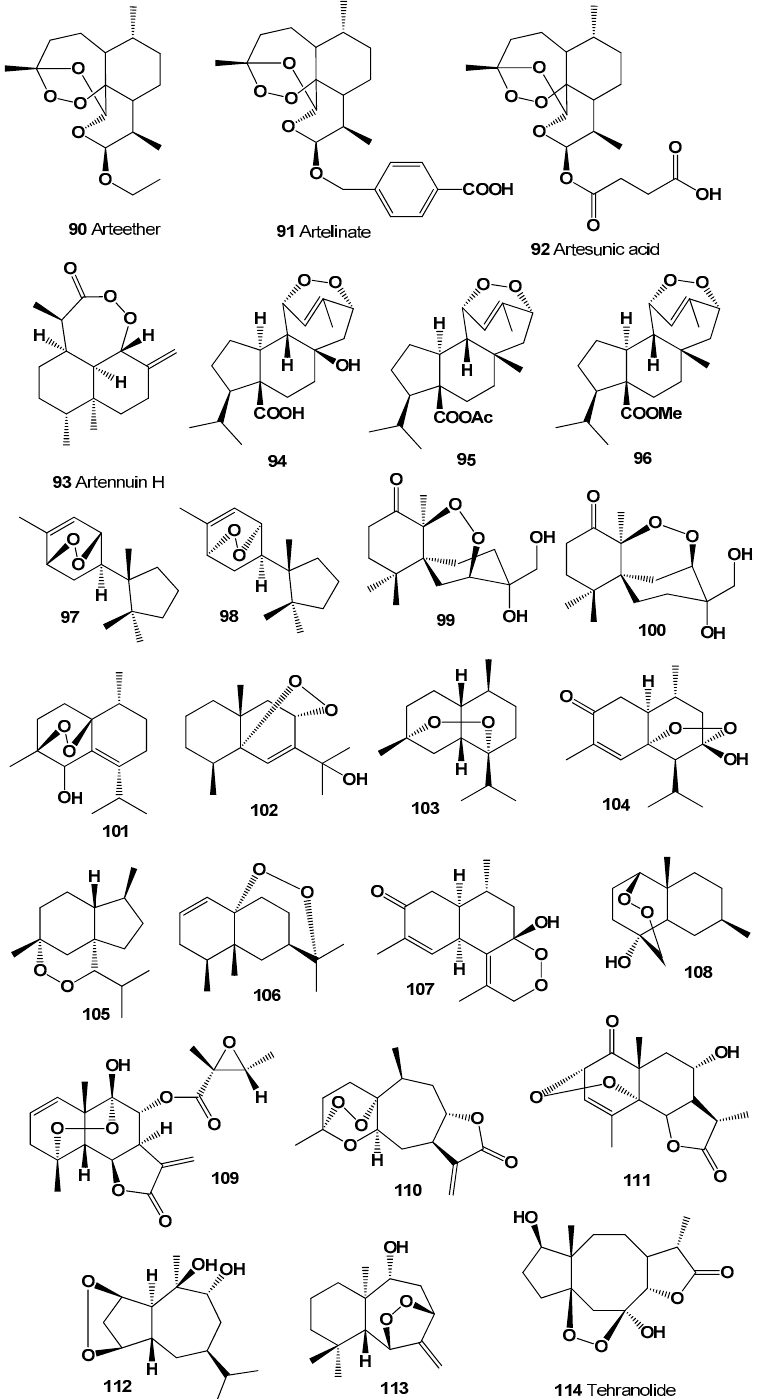
Figure 6. Bioactive polycyclic endoperoxides derived from plants and liverworts. Endoperoxy cuparene-type sesquiterpenoids ( 97 and 98 , structures are shown in Figure 6, and activity is shown in Table 7) were identified from the Japanese liverwort Jungermannia infusca [184,185]. The chamigranes called merulin B ( 99 ) and C ( 100 ) have been found in an extract of the culture broth of a Thai mangrove-derived fungus [186,187]. Muurolane sesquiterpene endoperoxide, 1,4-peroxy-5-hydroxy-muurol-6-ene ( 101 ) has been obtained from plant Illicium tsangii (family Schisandraceae) [188–190]. The peroxide called schisansphene A ( 102 ) was isolated from the plant Schisandra sphenanthera , also known as the magnolia berry [191].